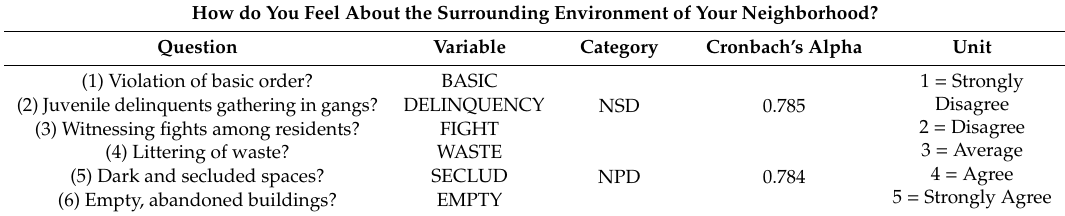
Table 2. Question of neighborhood level disorder perception.